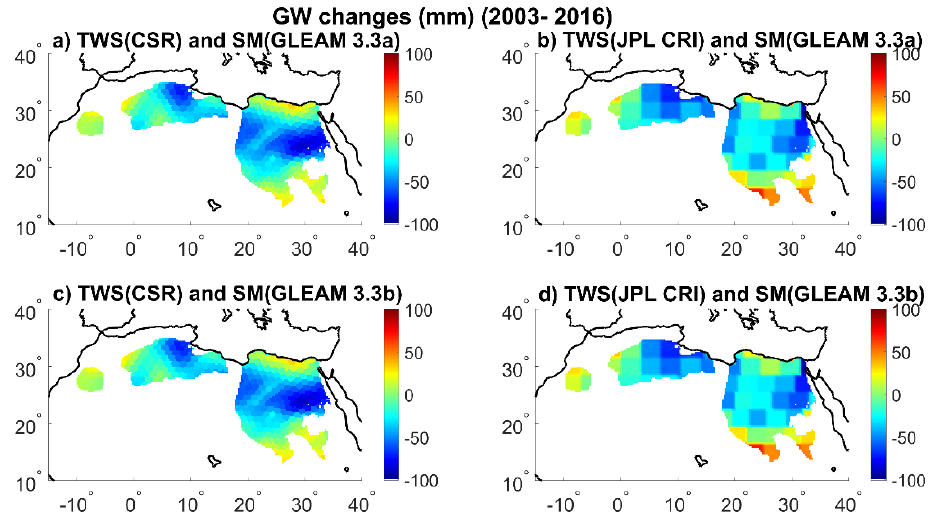
Figure 7. Changes in GW storage, expressed in terms of equivalent water height (mm) using GRACE-based TWS from mascon CSR RL06 and SM from GLEAM 3.3a ( a ); GRACE-based TWS from mascon JPL CRI RL06 and SM from GLEAM 3.3a ( b ); GRACE-based TWS from mascon CSR RL06 and SM from GLEAM 3.3b ( c ); and mascon JPL CRI RL06 and SM from GLEAM 3.3b ( d ) between 2003 and 2016 for TAS, NWSAS and NSAS. These changes in GW storage anomaly were computed using a 13-month averaging window.